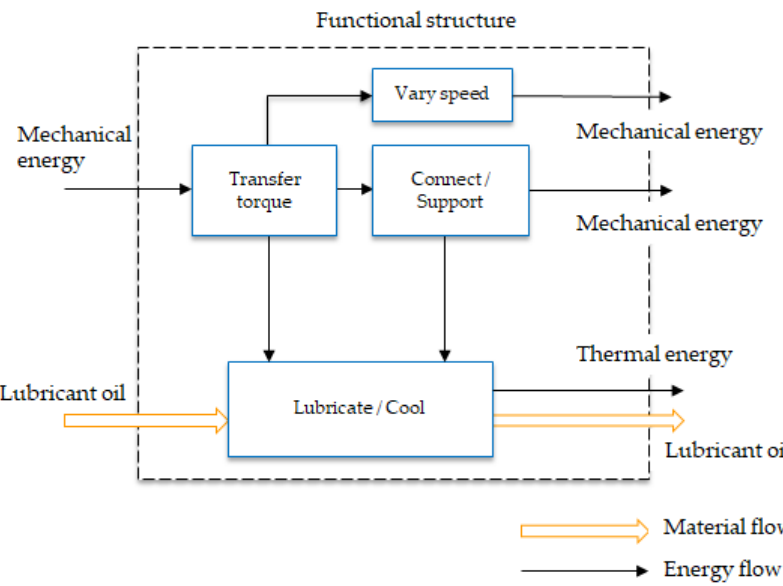
Figure 9. Function analysis of the final reduction of a tractor transmission.